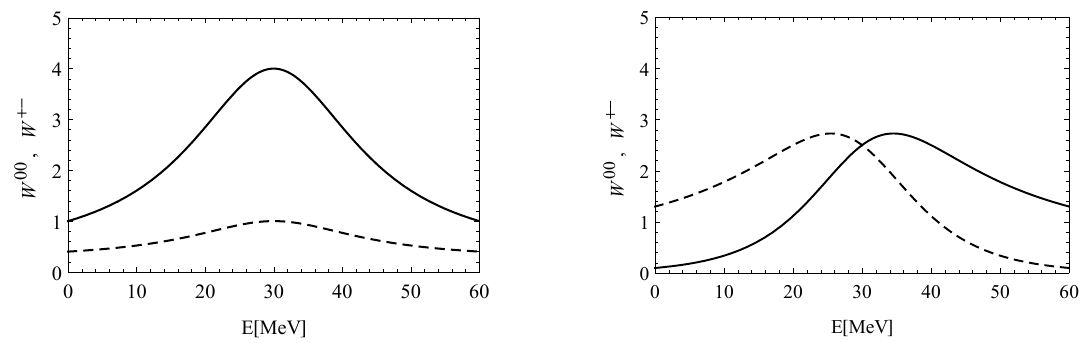
Figure 5 . Energy dependence of the probabilities W 00 (solid line) and W + − (dashed line) in units of W +0 for | C | = 45 MeV, arg C = π/ 2 (left figure) and arg C = 0 (right